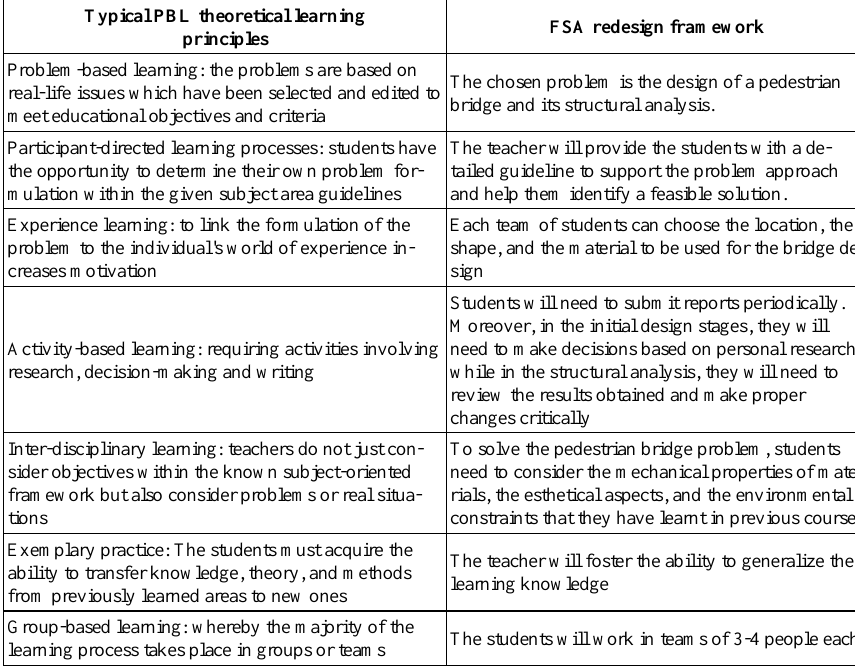
Table 1. Course design based on the typical theoretical PBL learning principles (the first column refers to